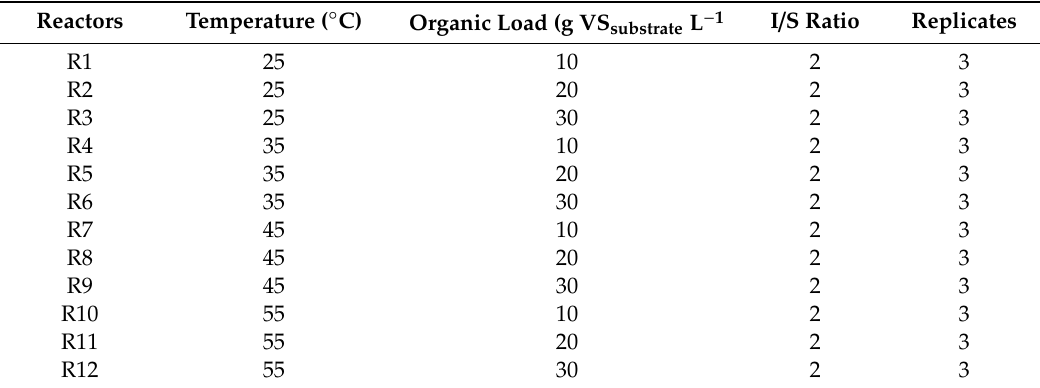
Table 2. Process conditions applied in the batch